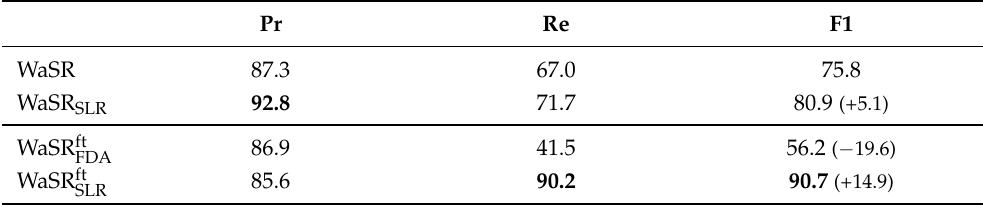
Table 4. Domain generalization performance on the SMD test set [30]. Models are trained on MaSTr1325 and the bottom two are additionally fine-tuned on the SMD training set. Best results for each metric are denoted in bold.